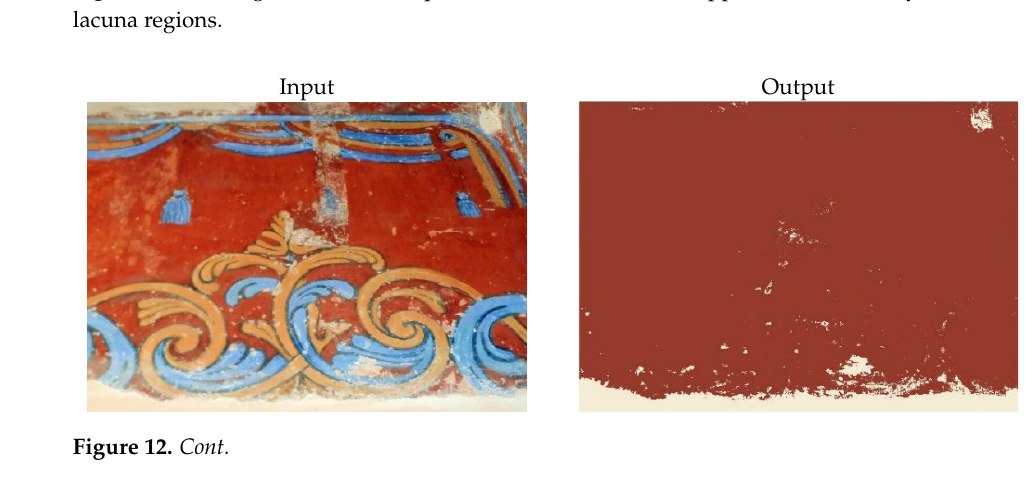
Figure 11. The original and the output of mural one. The MD approach successfully extracted the lacuna regions.